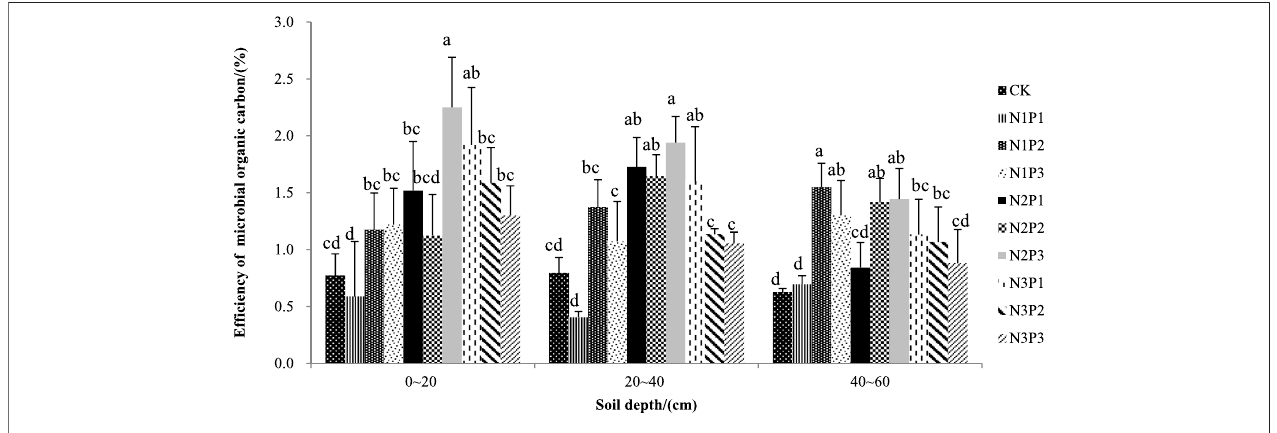
FIGURE 1 | The ef fi ciency of soil labile organic carbon under different fertigation treatments (N 1 – N 3 : 40, 60, and 80 mg L − 1 , respectively; P 1 – P 3 : 10, 20, and 30 mg L − 1 , respectively). (A) Ef fi ciency of easily oxidized organic carbon; (B) Ef fi ciency of dissolved organic carbon; (C) Ef fi ciency of microbial organic carbon. Data are the mean ± standard error ( n = 3). Different lowercase letters above the column indicate signi fi cant difference among treatments at the 0.05 signi fi cance level.